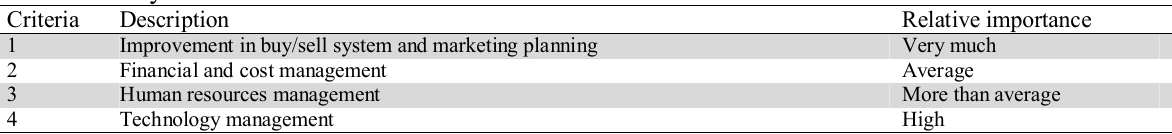
The summary of four criteria